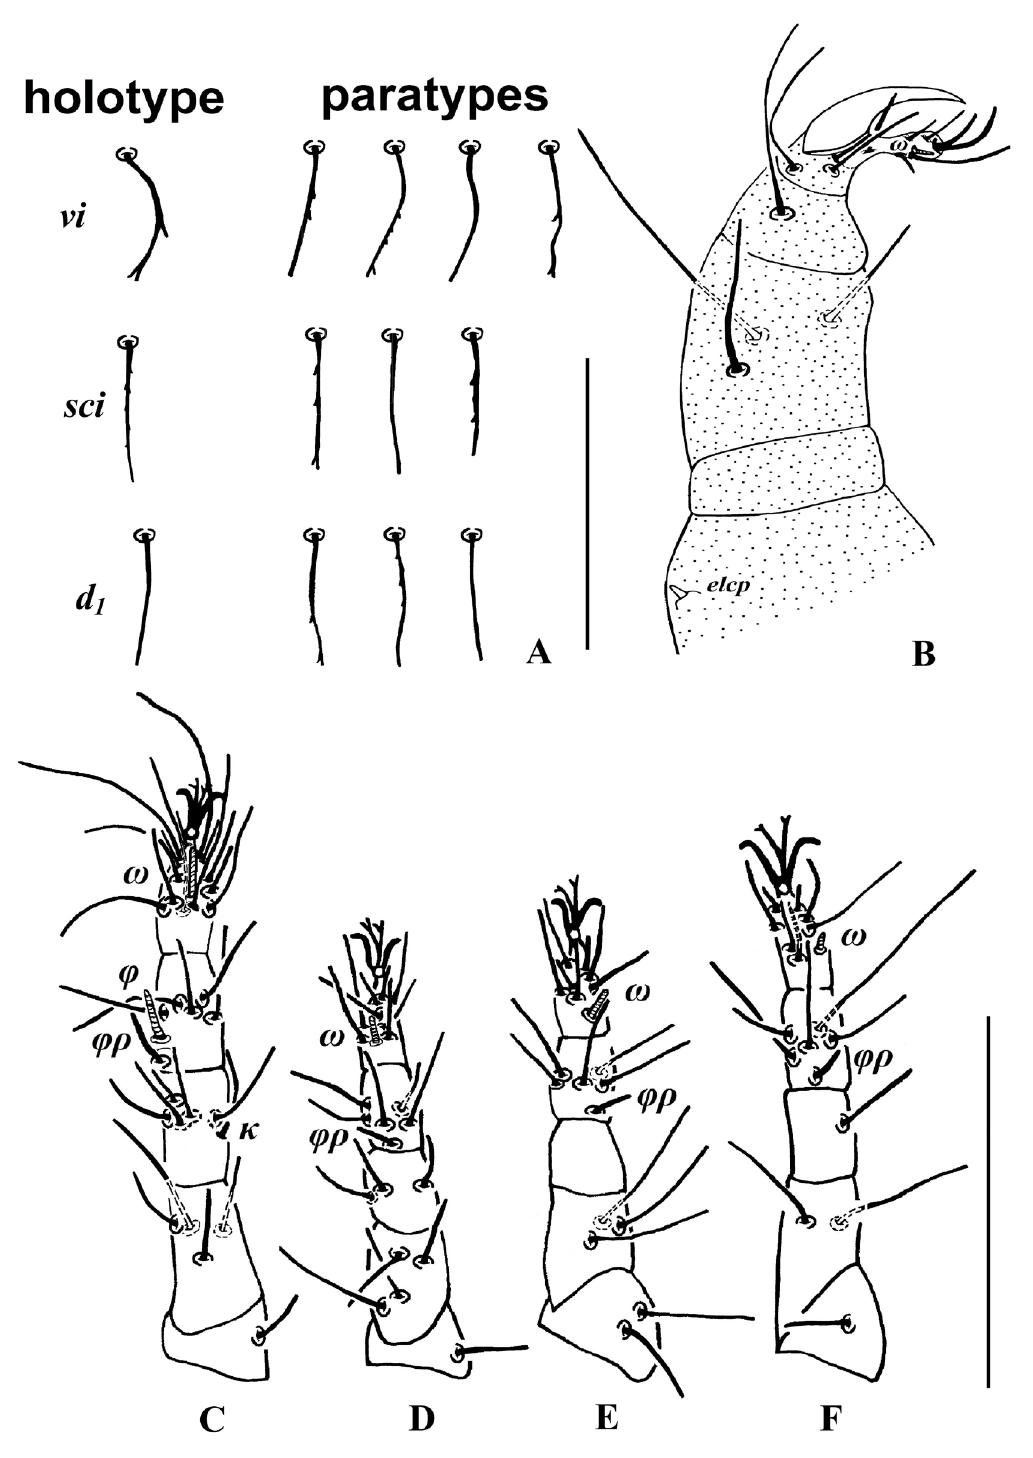
Fig. 2. Stigmaeus bifurcus sp. nov., holotype, ♀. A . Some dorsal body setae. B . Palp. C . Leg I. D . Leg II. E . Leg III. F . Leg IV. Scale bars: A–B = 40 μm; C–F = 100